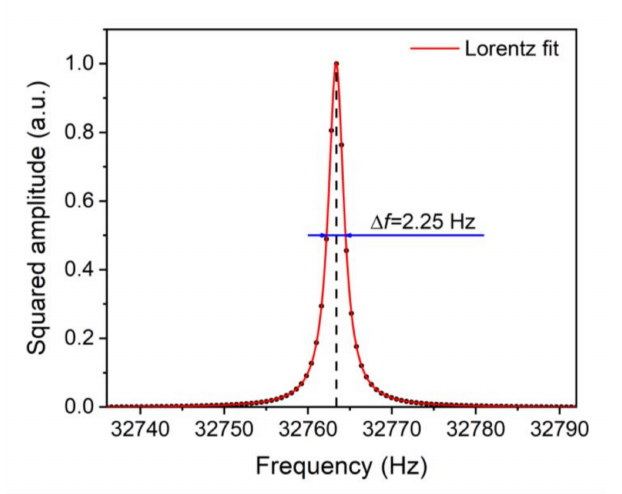
Figure 4. Normalized and squared amplitude as a function of